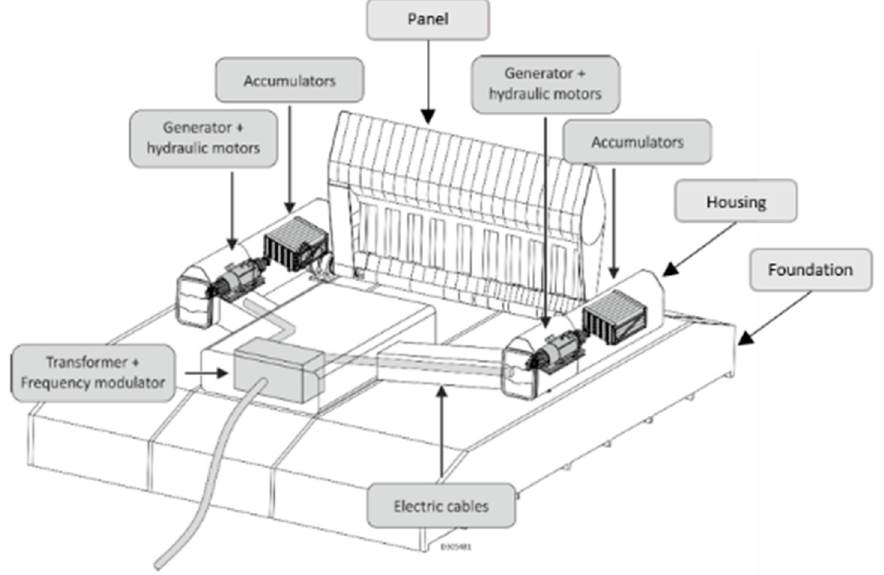
Figure 2. Early design of the MegaRoller device.